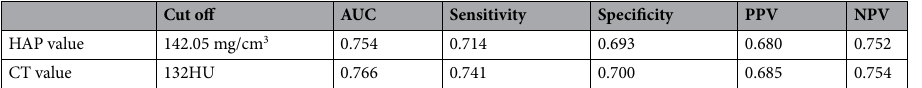
Table 2. The performance of HAP concentration and CT value in DECT in diagnosing osteoporosis. HAP and CT-value assessment derived from DECT both showed high diagnostic accuracy for the detection of osteoporosis with a significant difference regarding the overall AUC. AUC: area under the curve, NPV: negative predictive value, PPV: positive predictive value.